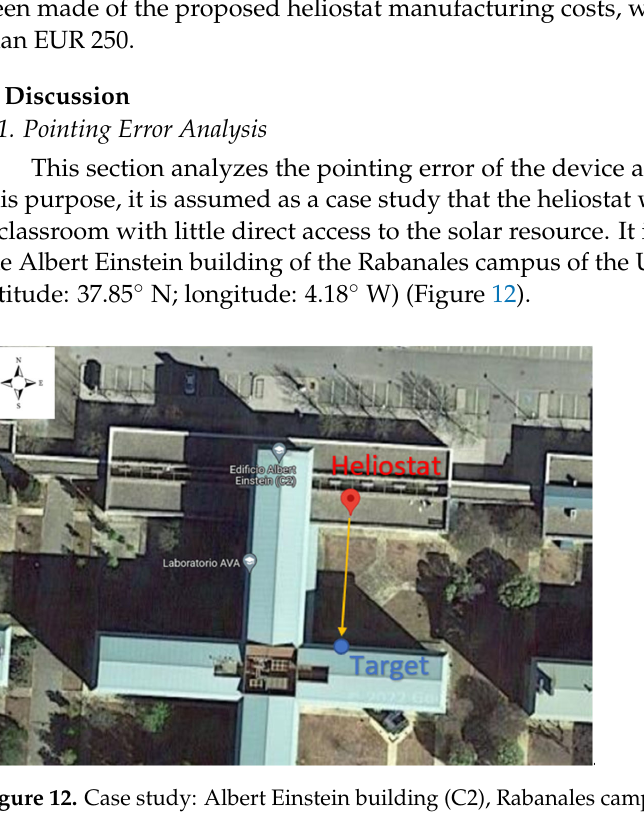
Figure 11. Device designed for mounting the proposed heliostatic illuminator.